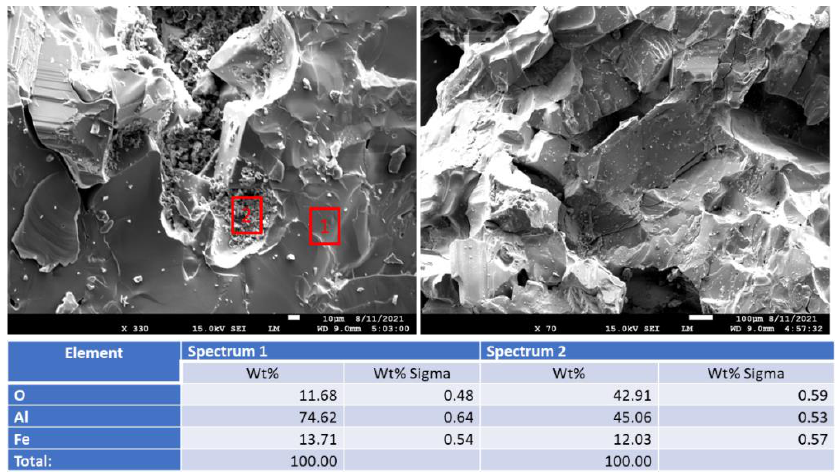
Figure 33. Photomicrograph of an anorthite sample with the elemental composition of typical sites shown by the red boxes after 3 cycles of thermal shock (one cycle: 600 °C heat → cold water quenching).